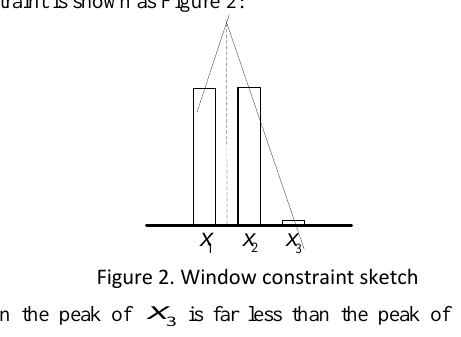
Figure 1. Peak calculation sketch